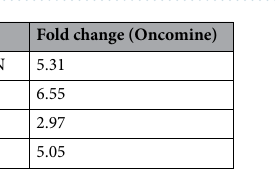
Table 4. The average fold change seen in candidate genes in Oncomine